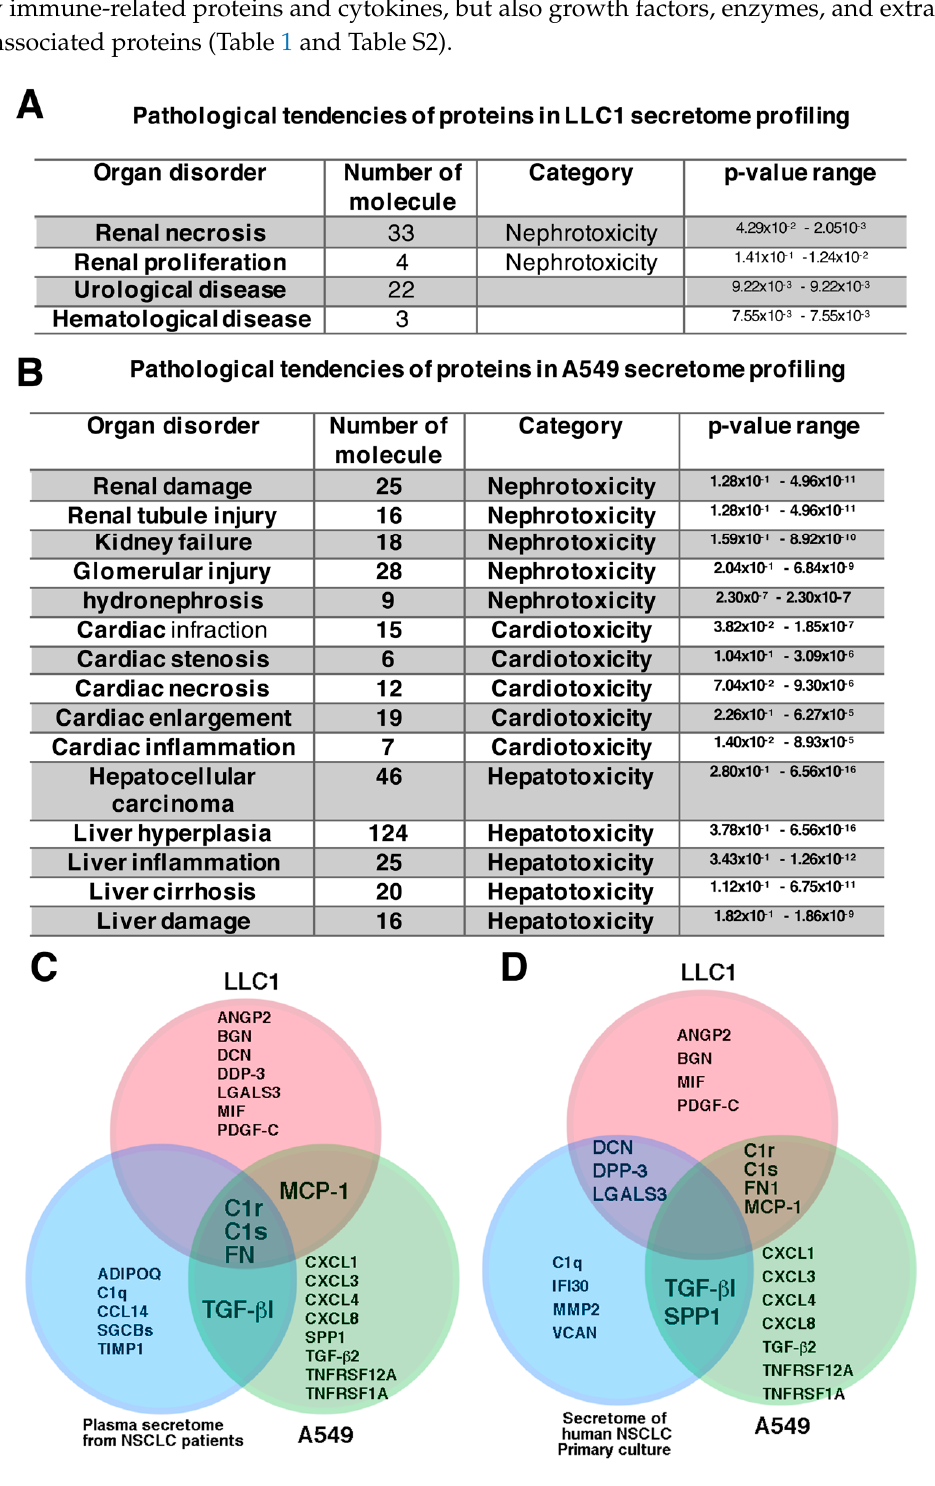
Figure 3. Ingenuity pathway analysis of the proteins identified in lung cancer cell secretomes. ( A ) Classification of the involvement of LLC1 cell-derived secreted proteins in various diseases. ( B ) Classification of the involvement of A549 cell-derived secreted proteins in various diseases. ( C ) Overlap of proteins identified in the LLC1 and A549 cell secretomes in the present study and serum secretome of non-small cell lung cancer (NSCLC) patients by Shin et al. [34]. ( D ) The commonly and di ff erentially expressed secretory proteins in LLC1 cells and A549 cells in the present study and in the human NSCLC primary culture reported by Feng et al.